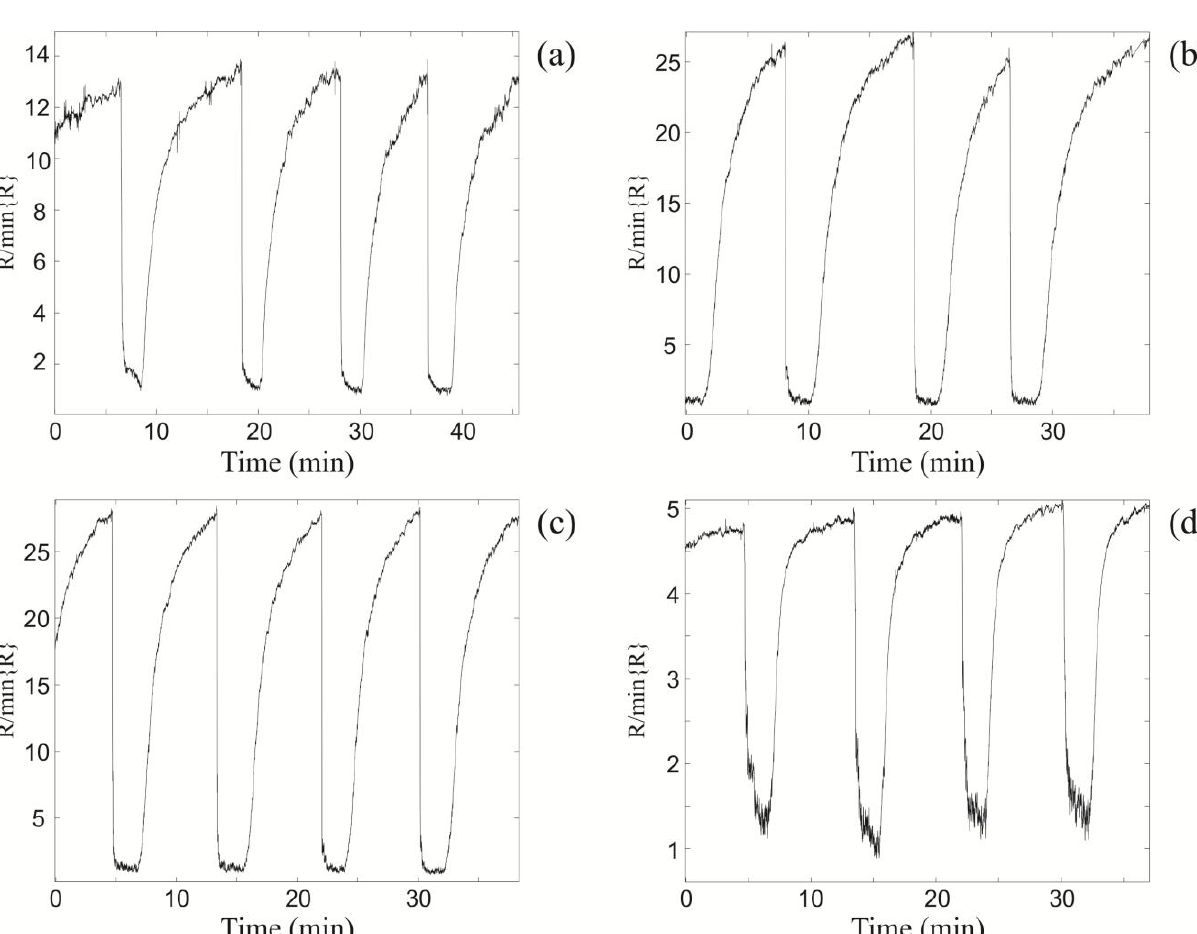
= 435 °C. ( a ) T = 100 LB V